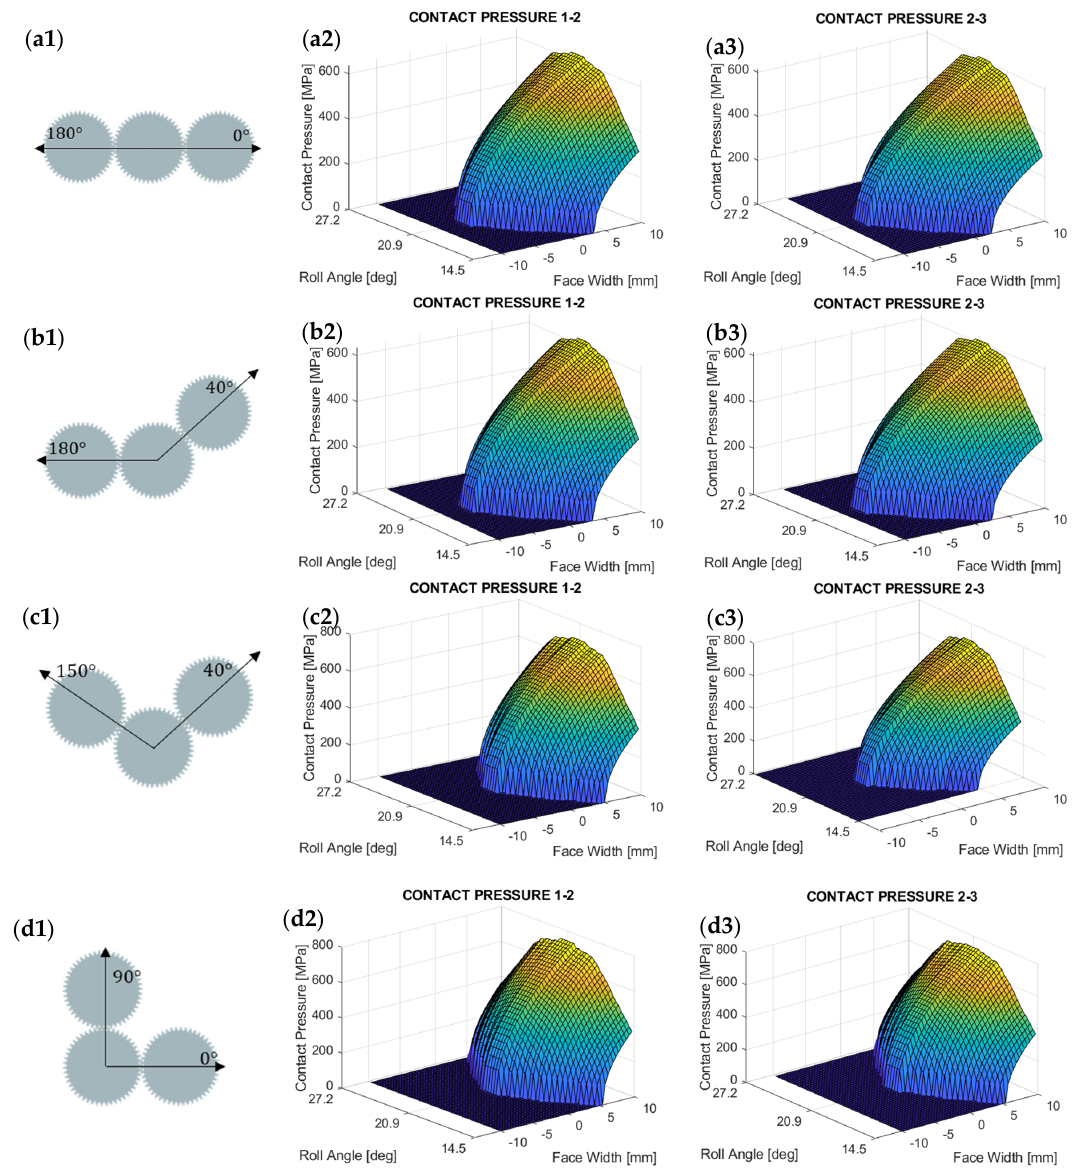
Figure 15. Contact pressure distribution in gear pairs 1–2 and 2–3, respectively. ( a1 – a3 ) 0–180 ◦ positions. ( b1 – b3 ) 40–180 ◦ positions. ( c1 – c3 ) 40–150 ◦ positions. ( d1 – d3 ) 0–90 ◦